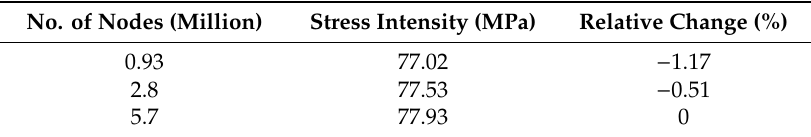
Table 5. Results of grid independence test for SG tube.